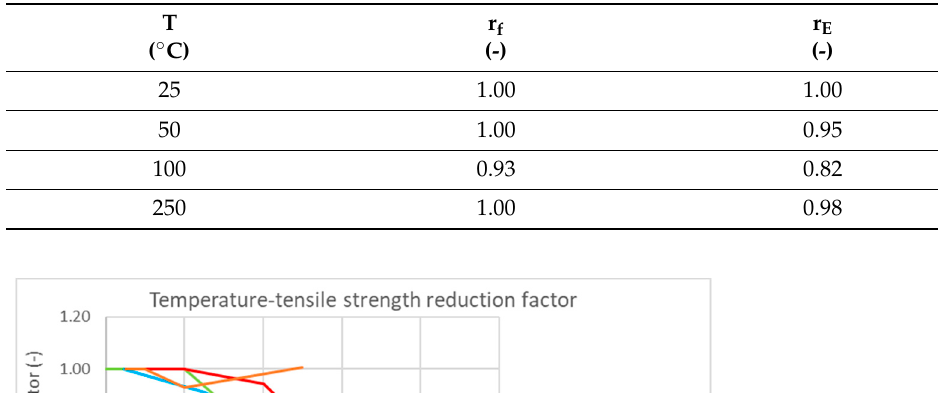
Table 7. Tensile strength and elastic modulus reduction factors of the present experimental work (CFRP-Experimental).